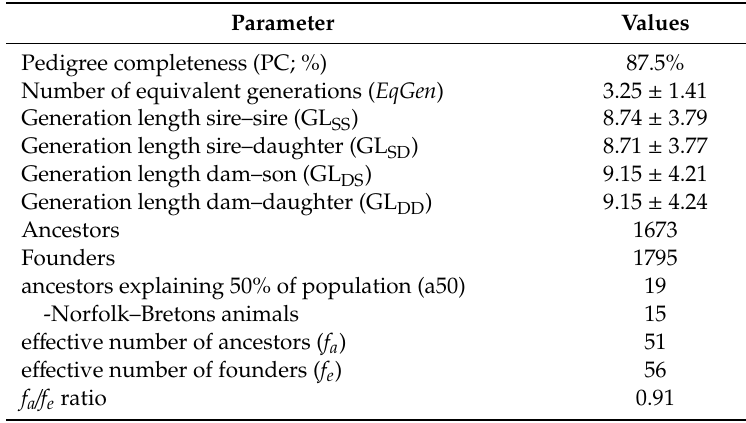
Table 2. Pedigree completeness and population genetic diversity in Italian Heavy Draught Horse from pedigree data. Number of equivalent generations and generation lengths are shown as mean ± standard deviation. Generation intervals, ancestors, founders, and related statistics refer to the reference populations, as individuals born in the last 10 years.